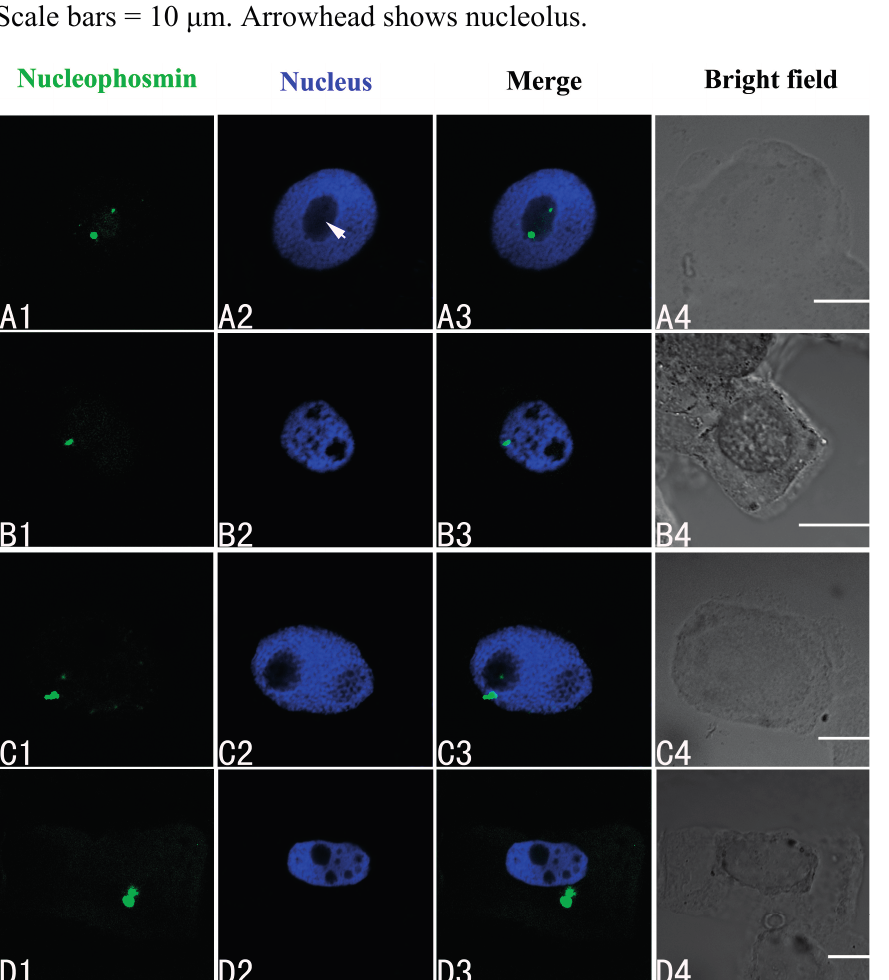
Figure 4. Simultaneous detection of nucleophosmin after incubation with primary anti-nucleophosmin antibody and secondary antibody conjugated with FITC (Fluorescein isothiocyanate) (green), and of DNA after incubation with DAPI (4',6-diamidino-2-phenylindole) (blue) in the same single optical section using confocal microscopy. ( A1 , B1 , C1 , D1 ) Nucleophosmin detection; ( A2 , B2 , C2 , D2 ) DNA detection; ( A3 , B3 , C3 , D3 ) Merged image of “nucleophosmin detection” and “DNA detection”; ( A4 , B4 , C4 , D4 ) bright field image. ( A1 – A4 ) Nucleophosmin mainly localized in the nucleolus of control cells; ( B1 – B4 ) The migration of nucleophosmin from the nucleolus to the nucleoplasm in cells treated with 100 μ M Pb for 24 h; ( C1 – C4 ) The movement of nucleophosmin from the nucleoplasm into the cytoplasm in cells treated with 100 μ M Pb for 48 h; and ( D1 – D4 ) Nucleophosmin in the cytoplasm of cells treated with 100 μ M